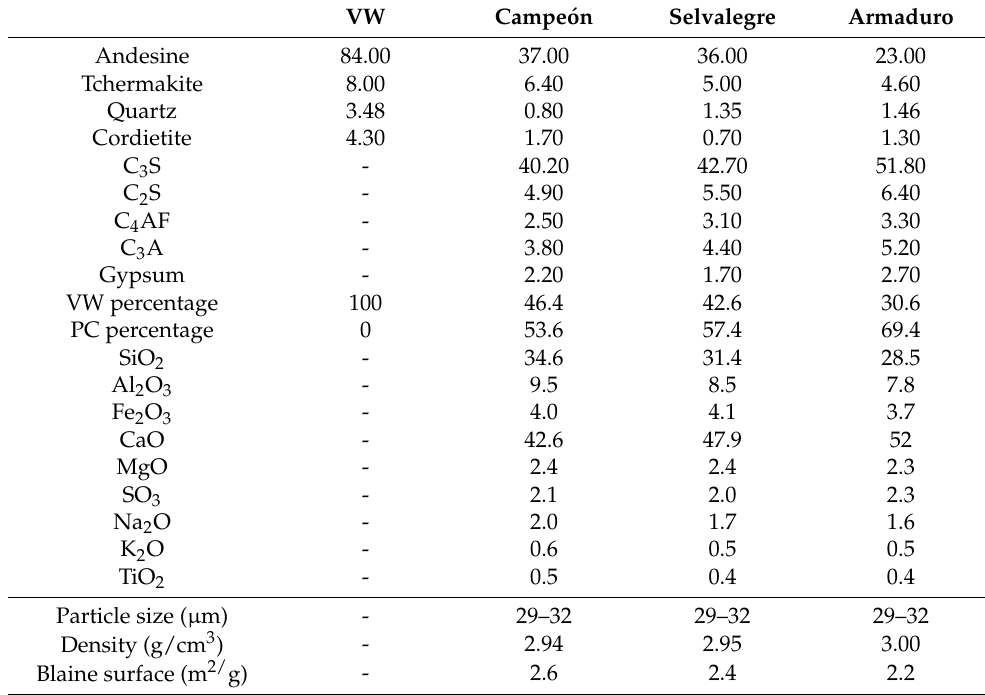
Table 1. Mineralogical and chemical composition (% wt) of VW and